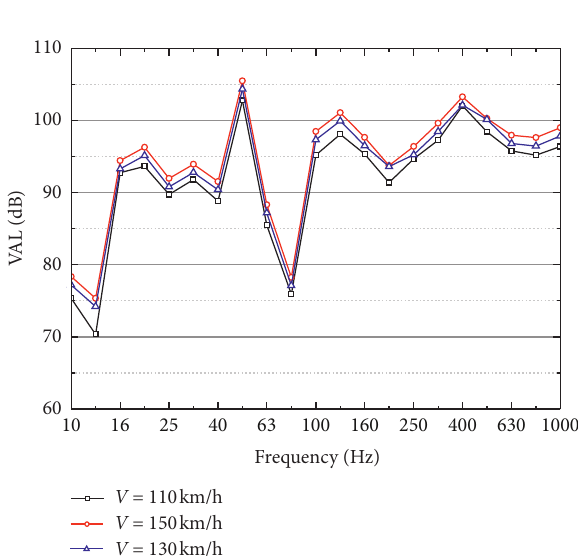
Figure 18: Vibrations at different